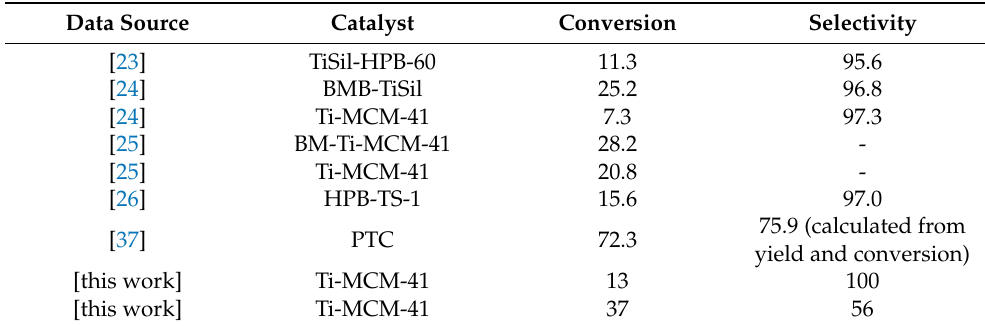
Table 6. Comparison of literature data on the results of the CDT epoxidation reaction with the results obtained in this